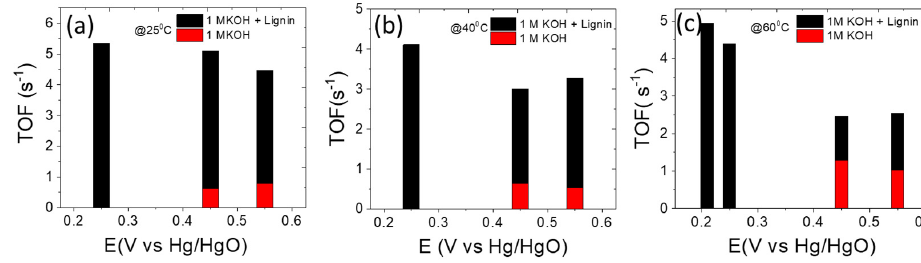
Figure 7. ( a – c ) Plots of the TOF values of